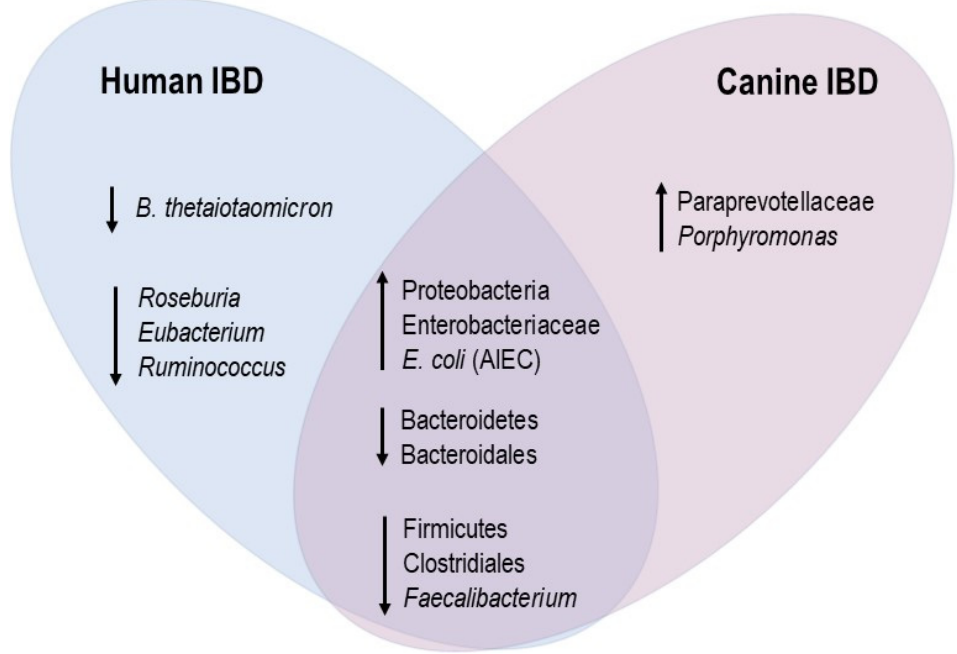
Figure 4. Bacterial features associated with human and canine